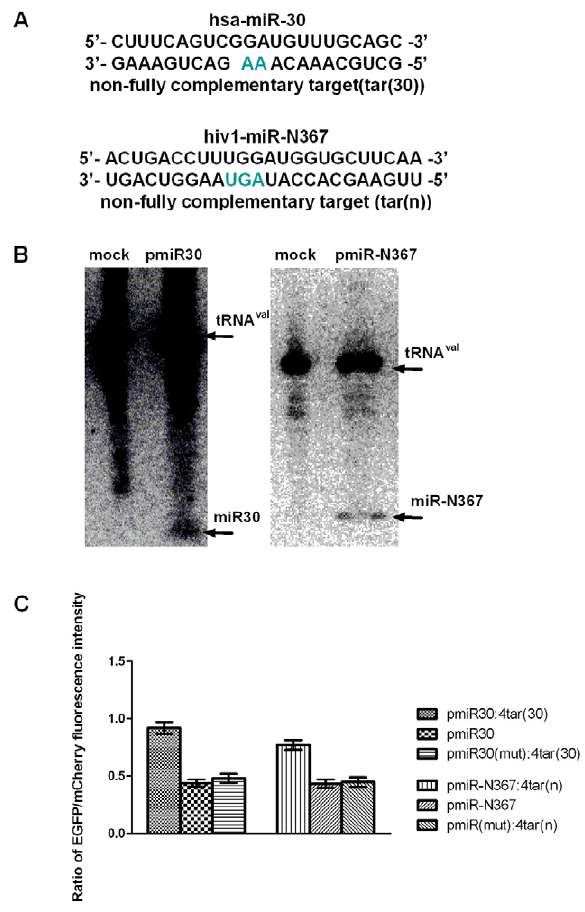
Figure 2. Validation of the dual-fluorescent protein reporter system as an miRNA functional assay. (A) Sequences of miR30, hiv1-miR-N367 and their non-fully complementary targets. (B) Northern blot analysis of the transcription of specific miRNAs. HeLa cells were mock-transfected (mock) or transfected with plasmids pmiR30, pmiR- N367 individually, and the location of the mature miR30 and miR-N367 is indicated. tRNA Val served as a loading control [26]. (C) Fluorescence reporter assay of the indicator vectors pmiR30:4tar(30), pmiR- N367:4tar(n) and their control vectors. HeLa cell cultures were transfected with the indicator vectors pmiR30:4tar(30), pmiR- N367:4tar(n) and their control vectors with miRNAs or target sequences only. The ratio of EGFP to mCherry fluorescence intensity is shown.